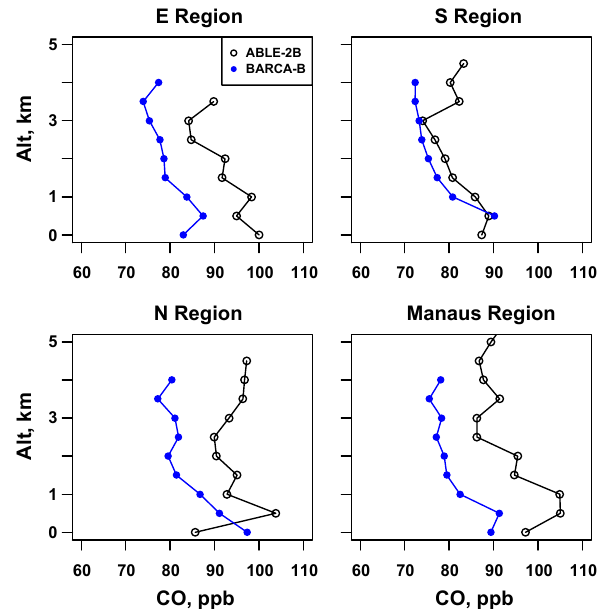
Fig. 10. Comparisons of median vertical profiles for the Equatorial Transect east of Manaus (“E. Region”), N and S transects along 60 ◦ W longitude, and near Manaus (excluding local pollution). Note the strong similarities between ABLE-2B and BARCA-B data taken more than 20 years apart. (Source of ABLE data: Harriss et al.,